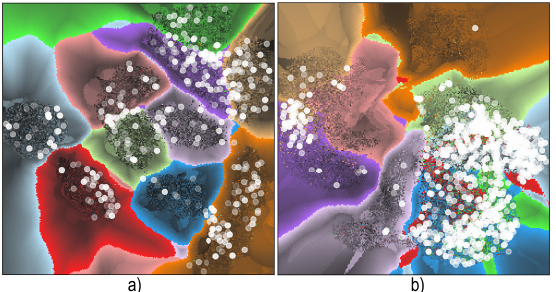
Figure 12. Misclassifications with opacity coding distance-to-boundary for ( a ) MNIST and ( b ) FashionMNIST